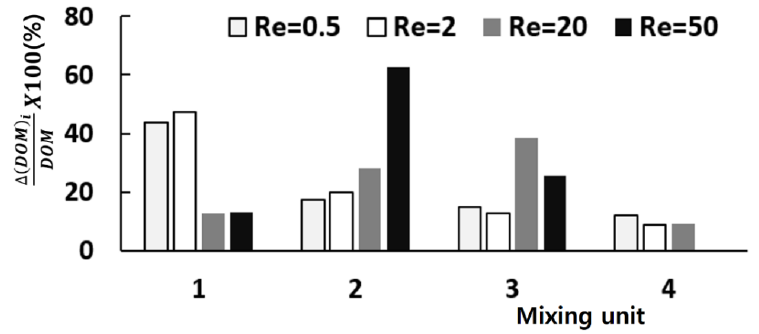
Figure 6. DOM obtained in each mixing unit.